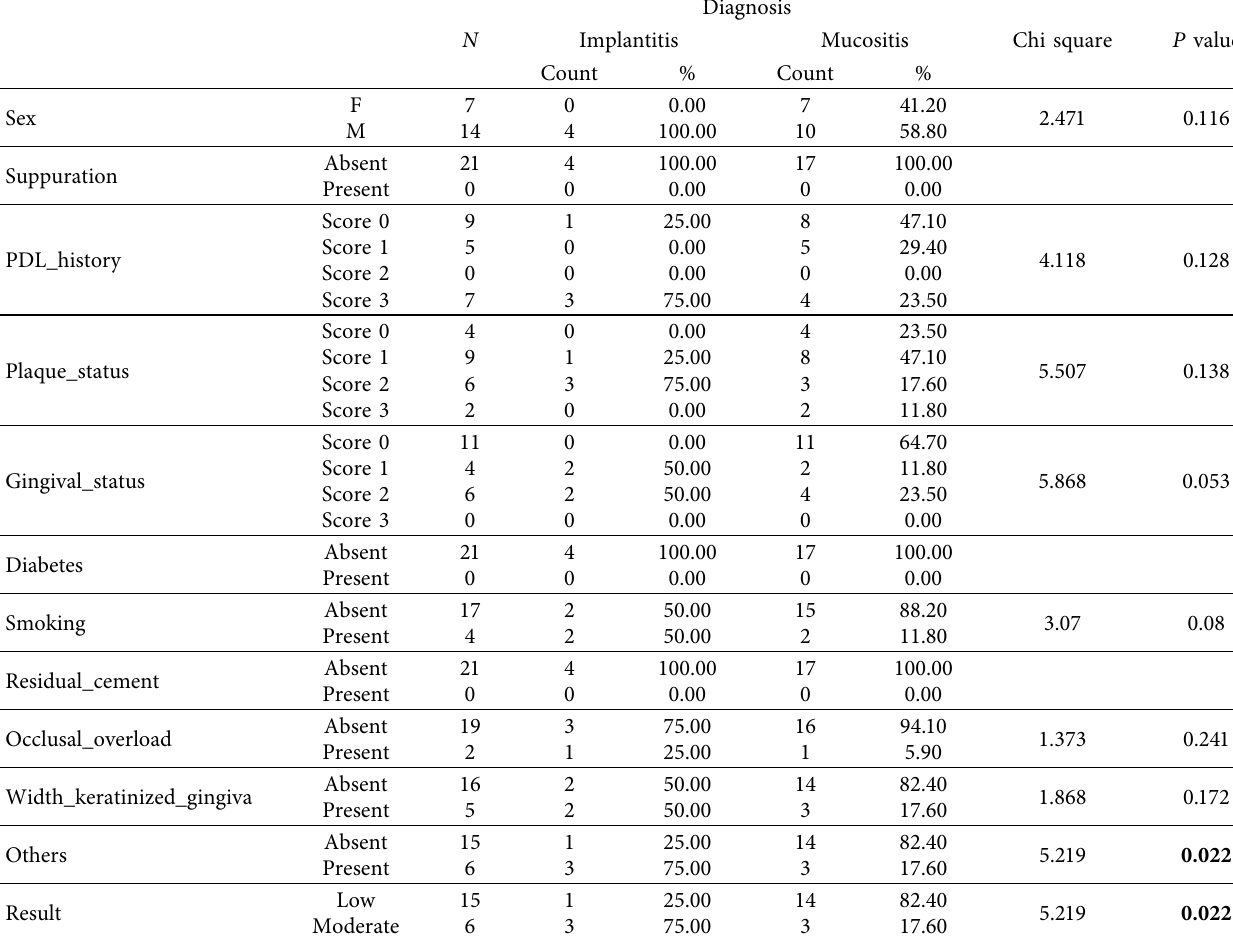
Table 3: Chi square test with various risk factors involved in peri-implant